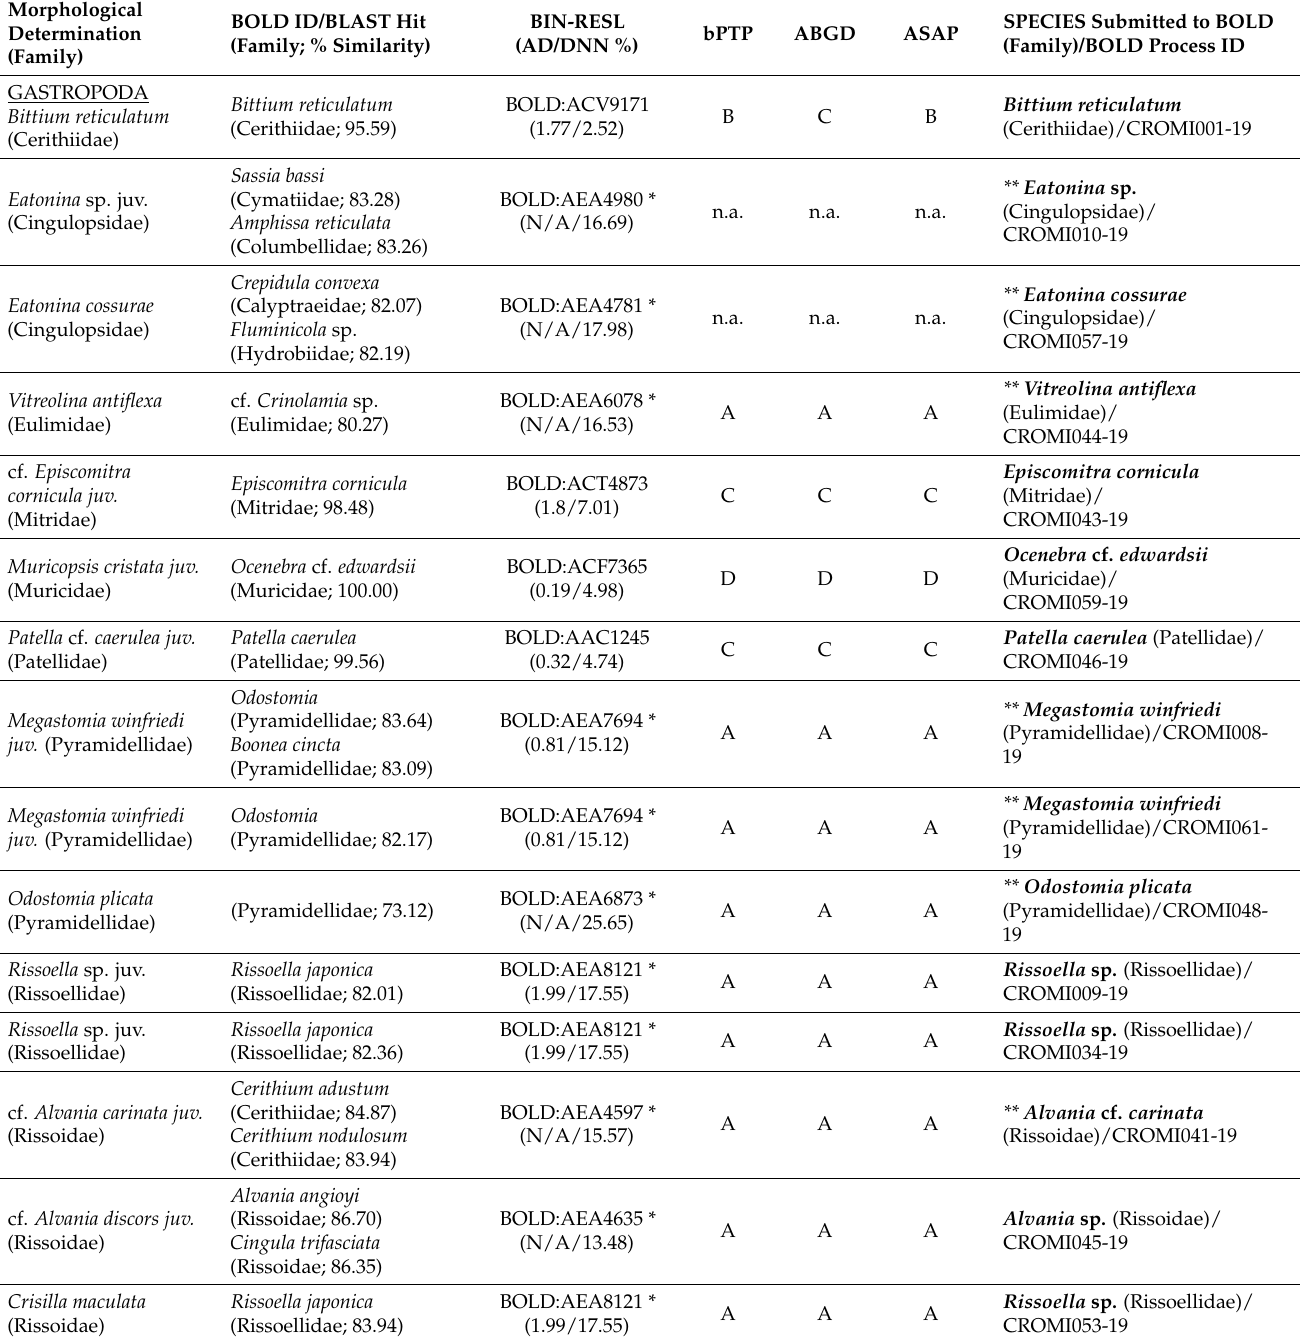
Table 1. Sequenced mollusks and their identification according to morphological features and DNA barcoding. AD: Average BIN Distance; DNN: Distance to Nearest Neighbor. Specimens classified in OTUs as recovered by species delimitation methods-A: OTU separate from all other BOLD entries and no additional OTUs with conspecific entries (as entered in BOLD); B: OTU separate from all other BOLD entries but there are also additional OTUs with conspecific entries; C: OTU composed of conspecific BOLD entries and there are no additional OTUs with conspecific entries; D: OTU composed of conspecific BOLD entries and there are additional OTUs with conspecific entries; E: OTU composed of conspecific BOLD entries and other morpho-species (discordant OTU); n.a.: species delimitation analyses were not performed since there are no confamiliar sequences in